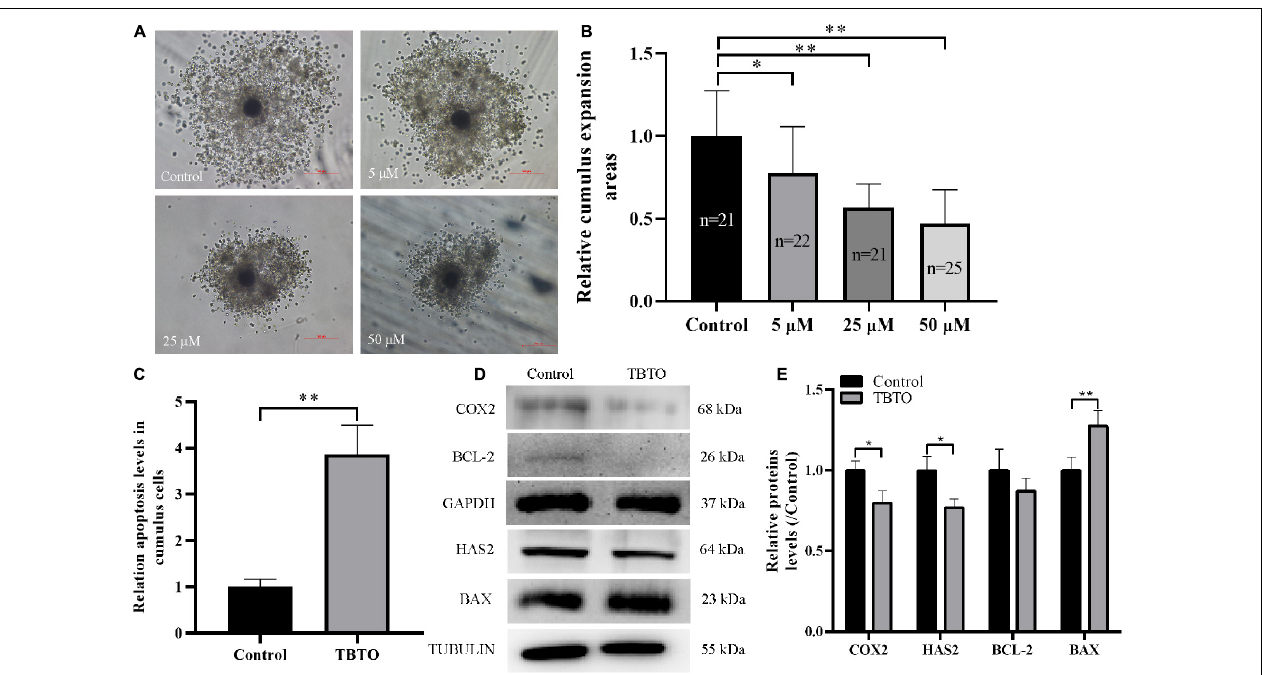
FIGURE 2 | Effects of TBTO exposure on the cumulus expansion status of porcine oocytes. (A) Representative images of cumulus expansion status in the control and TBTO exposure groups at the end of the IVM period. Scale bar = 200 µ m. (B) Relative cumulus expansion areas in the control and TBTO exposure groups. (C) Relative apoptosis levels in cumulus cells between control and TBTO exposure group by flow cytometry analysis. (D) Western blotting was used to detect the protein levels in cumulus cells between control and TBTO exposure group. (E) Histogram showing the relative levels of several proteins in TBTO exposure group compared to the reference proteins in the control group. The numbers of COCs examined from the different groups are indicated by the bars. ∗ p < 0.05; ∗∗ p < 0.01 compared to the control.